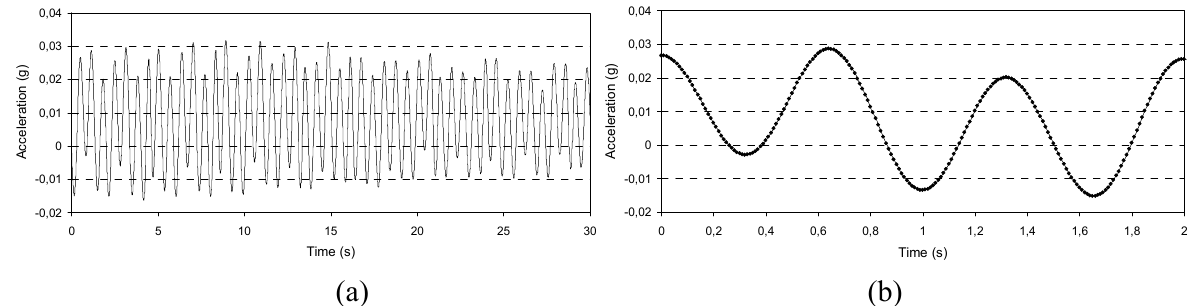
Figure 12. Sine sweep after dynamic excitation: 0.3 g amplitude, 0.5 Hz/s sweep ratio, y-axis. The horizontal lines correspond to the vibration level measured by the piezoelectric accelerometer used as feedback signal; (a) increasing (5–10 Hz) and (b) decreasing (10–5 Hz) frequency